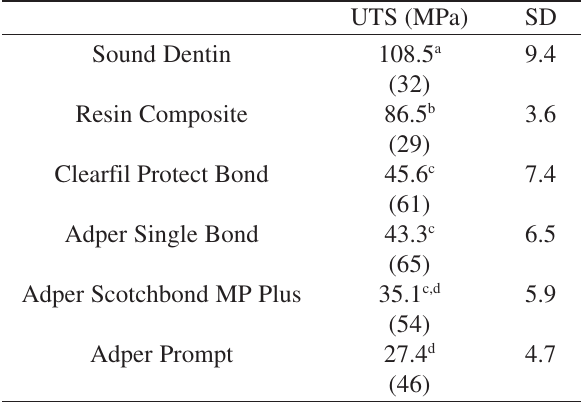
UTS - Ultimate tensile strength = force at failure/cross-sectional area. SD - Standard deviation. Values with same letters are not statistically different (p >